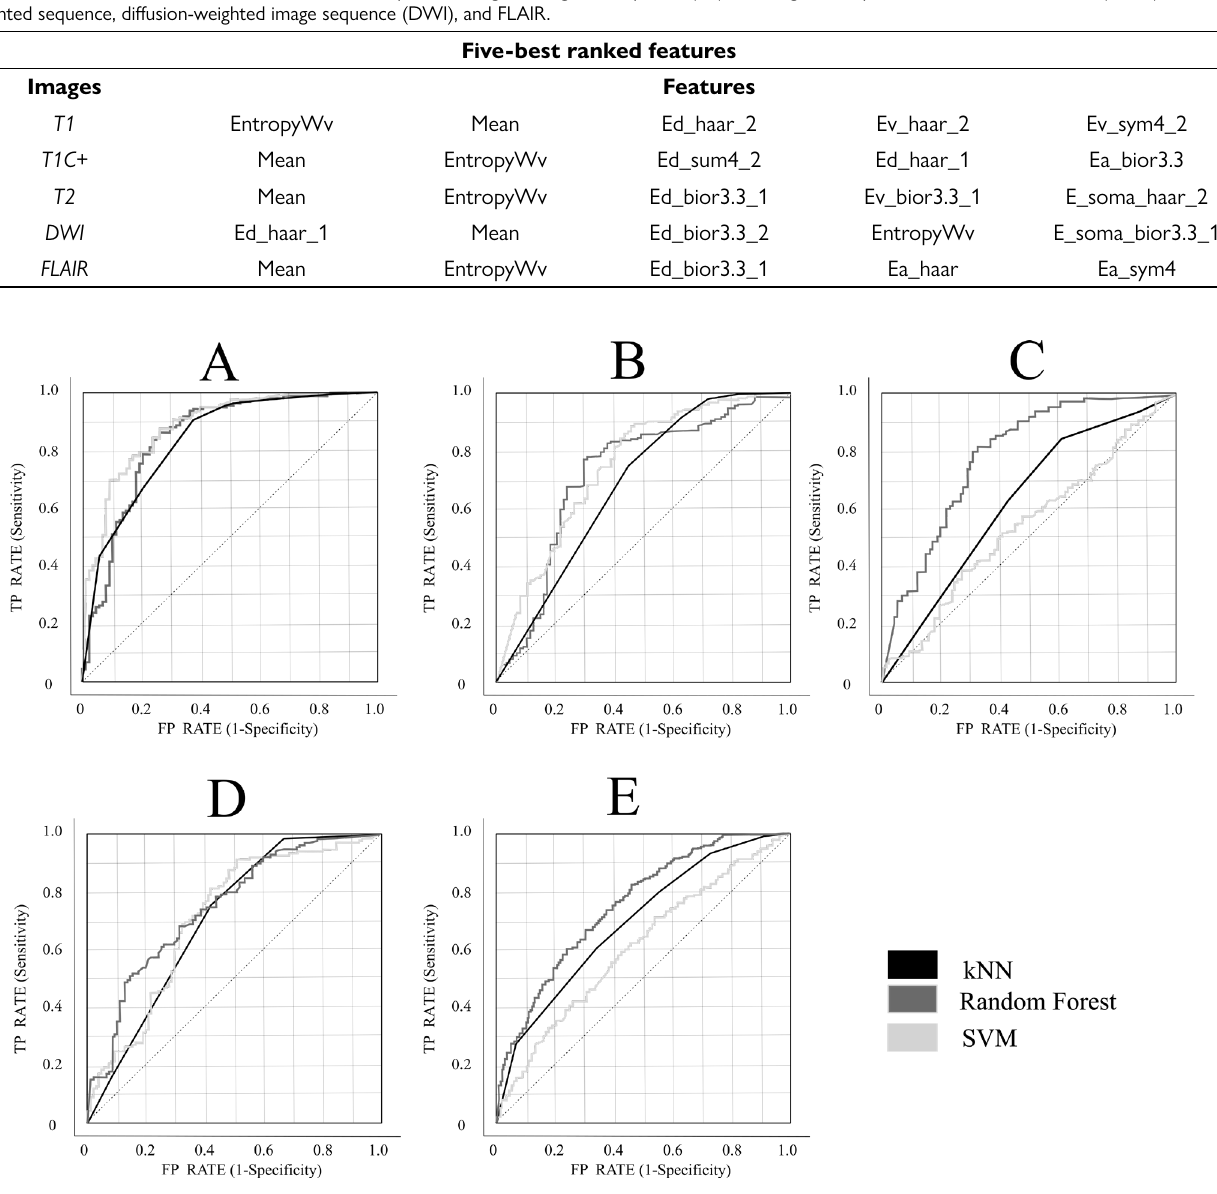
Figure 2. ROC curves of kNN, SVM, and Random Forest analysis. The classifiers on image (A) are applied to all images. (A) ROC curve from a T1-weighted image with the five best-ranked features. (B) ROC curve from T1 C+ image with the five best-ranked features. (C) ROC curve from T2-weighted image with the five best-ranked features. (D) ROC curve from DWI with the five best-ranked features. (E) ROC curve from FLAIR image with the five best-ranked